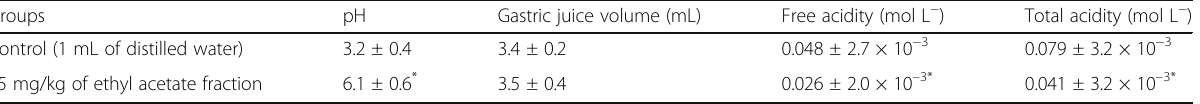
Table 1 Effect of ethyl acetate fraction of Trichosanthes cucumerina Linn. on pH, gastric juice volume, free acidity and total acidity Groups